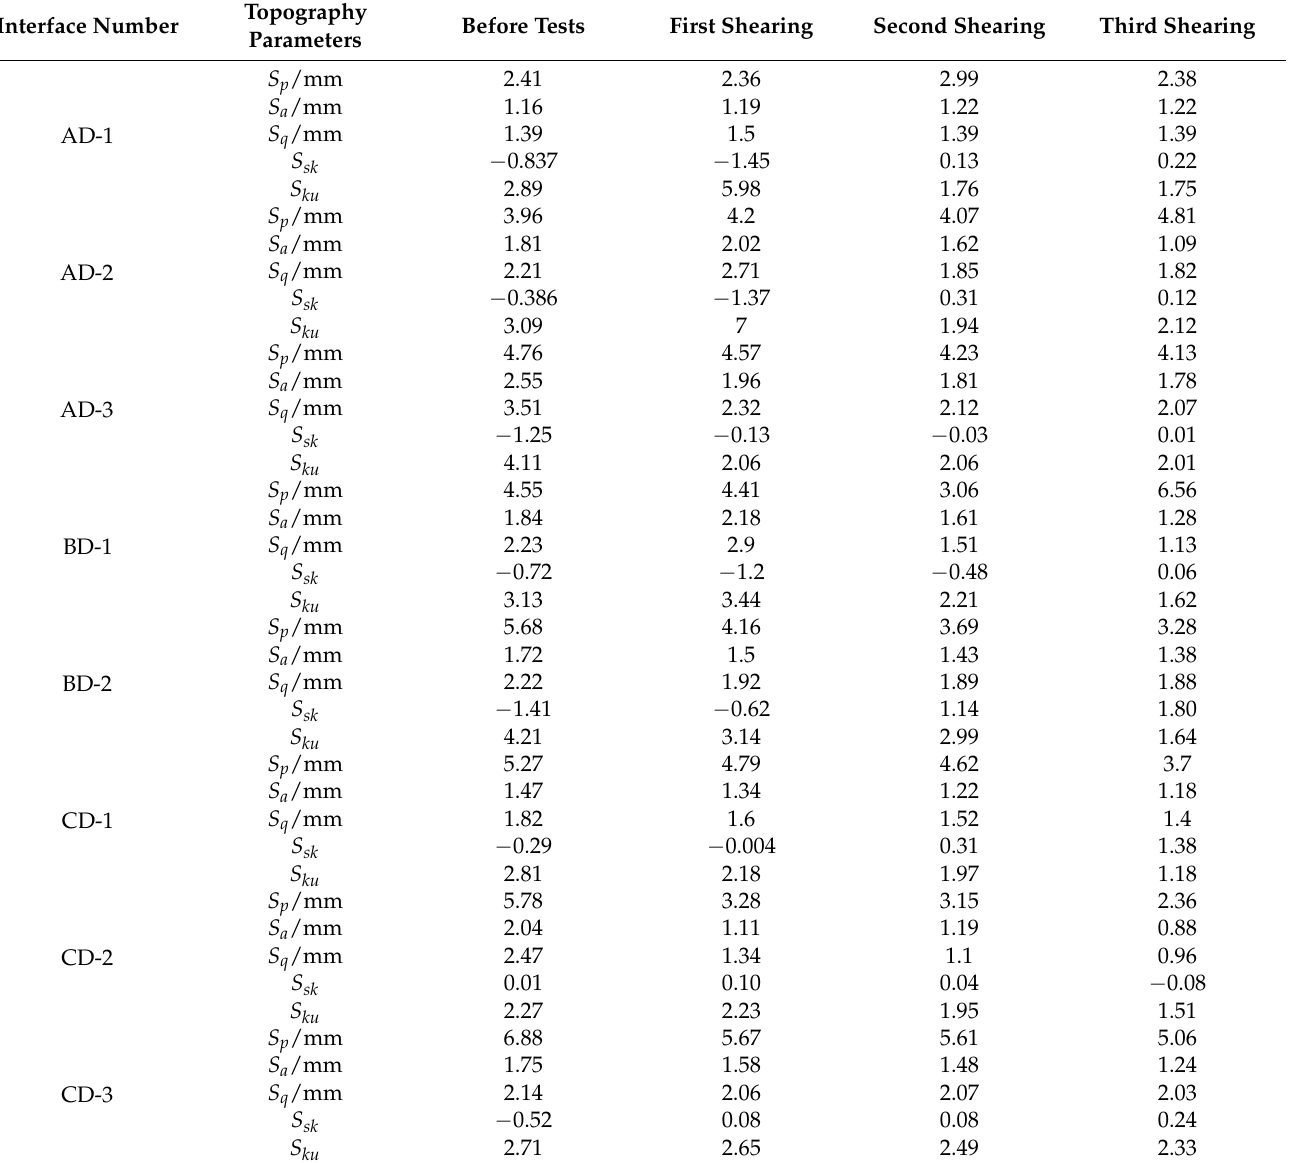
Table 4. High feature parameters of interface topography before and after